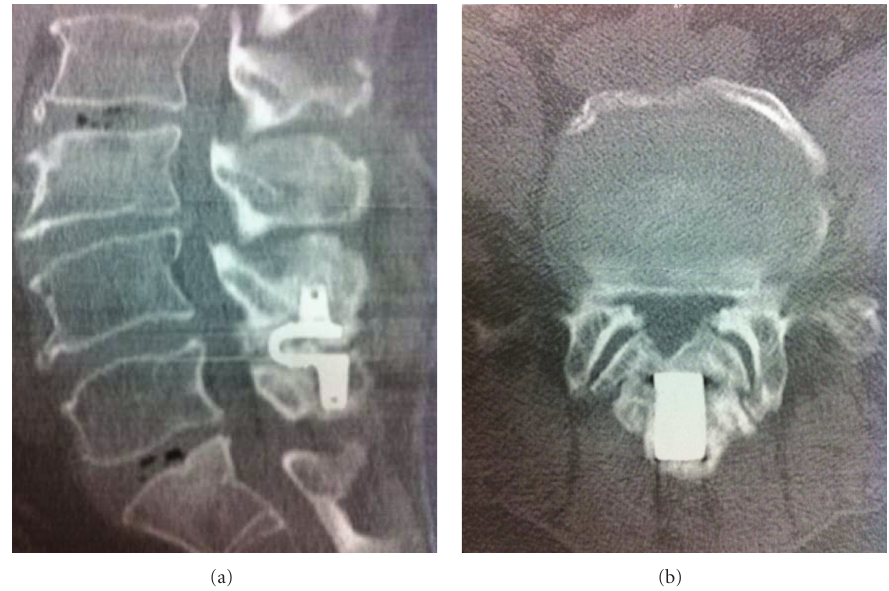
Figure 1: Preoperative CT bone scan showing heterotopic ossification of interspinous/interlaminar Coflex